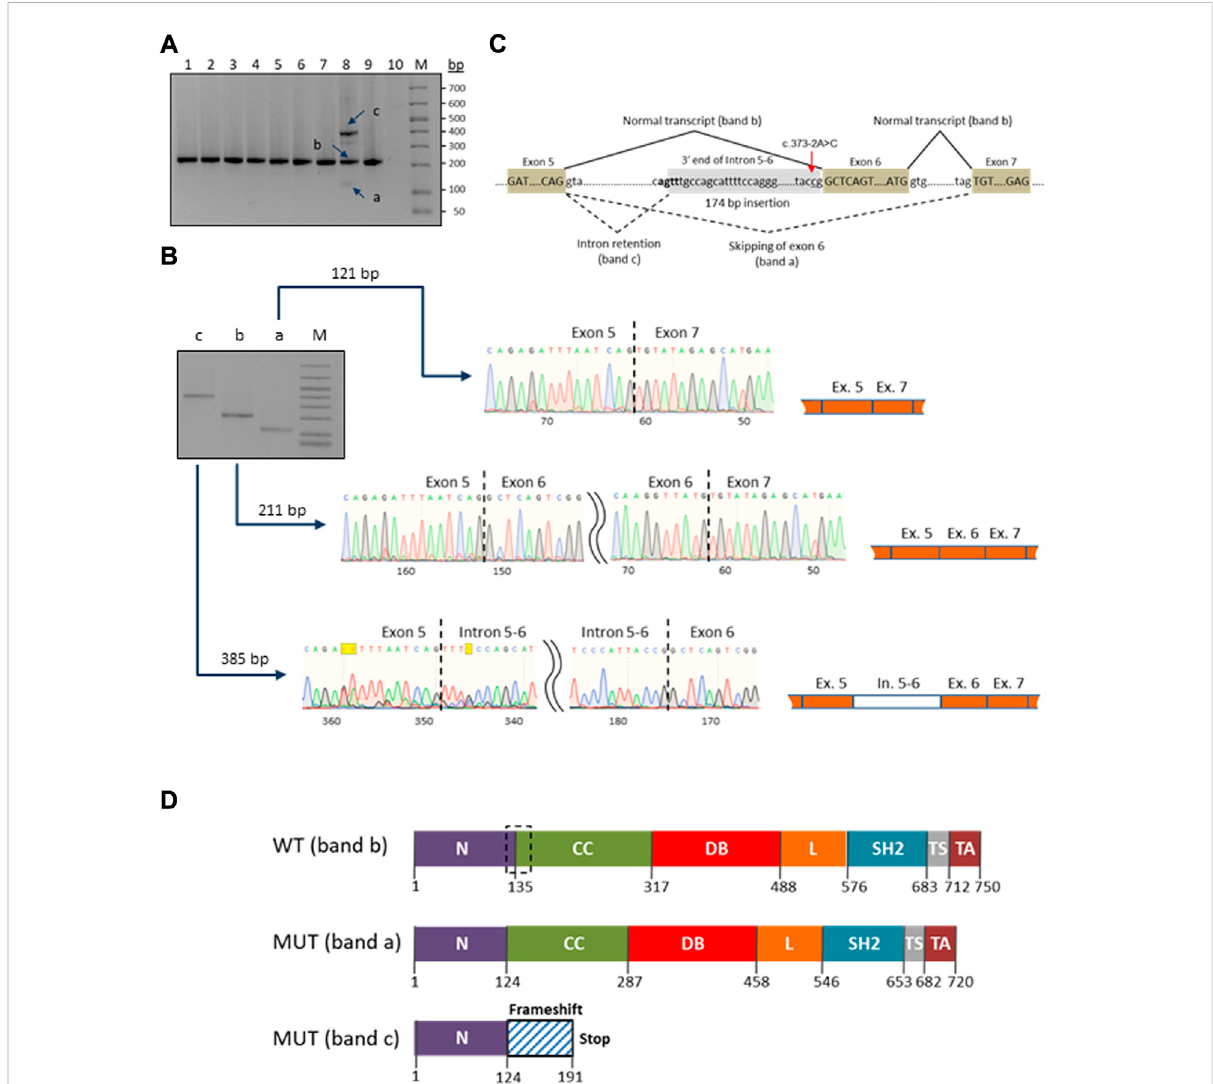
FIGURE 3 Characterization of the novel c.373 – 2A > C mutation in the STAT1 gene. (A) RT-PCR electrophoresis products on 2% agarose gel. The carrier patient (lane 8) showed three cDNA fragments (a, b and c) compared to one in the controls (lanes 1-7 and 9). (B) Puri fi cation and Sanger sequencing ofRT-PCRproducts.Sangersequencingrevealedcorrectlyspliced STAT1transcriptof211bp(lane b)andtwomutated transcripts:an aberrantshort fragment (121 bp, lane a) corresponding to the in-frame skipping of exon six and the aberrant long fragment (385 bp, lane c) corresponding to theout-of-frameretentionoftheintronicfragment. (C) Schematicrepresentationofthesplicingforthesplicesitemutationc.373-2A > C(redarrow). Thenewlygeneratedsplicesignalbetweenexons5-6isshowninbold.Exonsareshownasboxes. (D) Predictionofimpactofthesplicesitemutation c.373-2A > C on the STAT1 protein structure. Wild-type STAT1 is a multidomain protein of 750 amino acids. The mutant sequences are of 720 and 191 ammino acids length, corresponding to the short (exon six skipping/band a) and long (174 bp intronic fragment insertion/band c) transcripts/ bands, respectively. The structural domains within the protein are the coiled-coil domain (CC), DNA binding domain (DB), linker domain (L), SH2domain(SH2),tailsegmentdomain(TS),andtrans-activator domain(TA)areindicated,togetherwiththeiraminoacidboundaries.Dottedboxin the wild type sequence delimits the boundaries of the deleted region (30 amino acids) in the long mutant isoform (MUT band